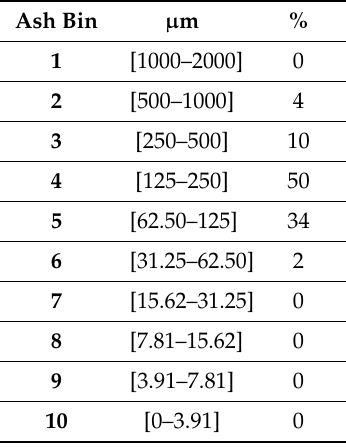
Table 3. Particle size distribution characterizing the particles emitted by Etna volcano, according to